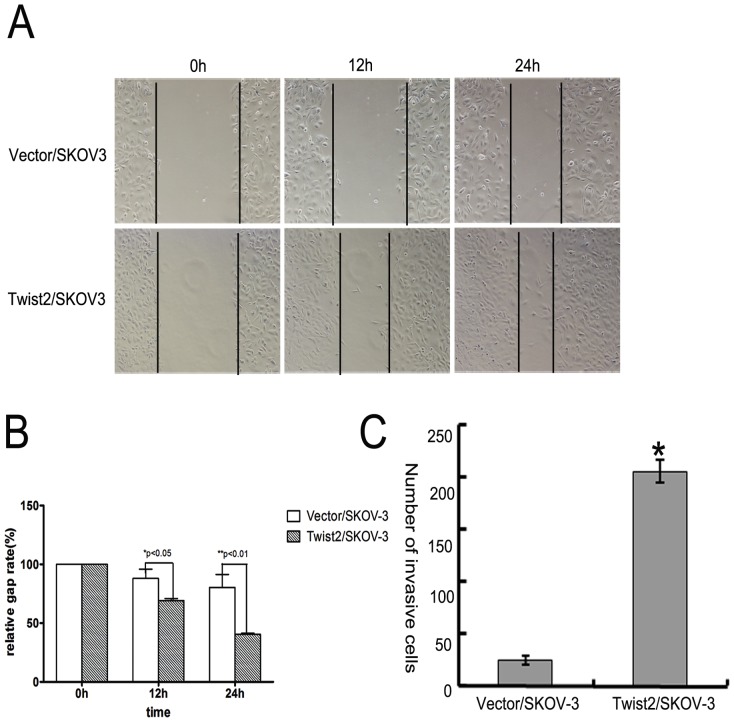
Overexpression of Twist2 in epithelial ovarian carcinoma cells increased cell migration, invasive potential in vitro.
A. In vitro wound healing assay of SKOV-3 cancer cells with or without Twist2 ectopic expression. Representative images of cells at “healing” sites at 12 and 24 hours after scraping are shown increased cell migration in Twist2/SKOV-3 cells. B. The analyzed migration results by the one way ANNOVA test (Graphpad Prism5 software). A P-value of 0.05 was considered statistically significant. The Twist2-expressing SKOV-3 cells migrated faster than the vector-transfected control cells. C. In vitro matrigel invasion assay of SKOV-3 cells with or without ectopic expression of Twist2. Quantification indicated that Twist2-expressing cells are 8–9 folds more invasive than the vector control cells in the in vitro matrigel invasion assay. *, p<0.005.